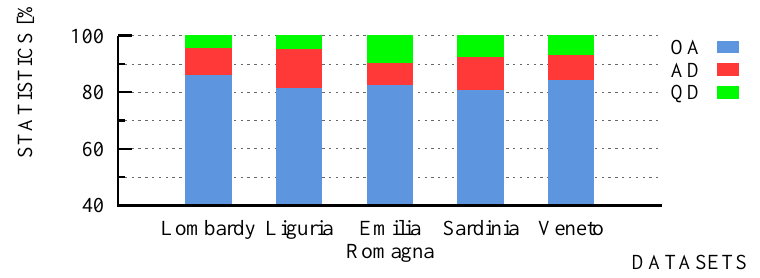
Figure 13. Comparison between GlobeLand30 2010 and Italian regional datasets (I reclassification, no buffer case): overall accuracy (OA), allocation disagreement (AD), quantity disagreement (QD) for each